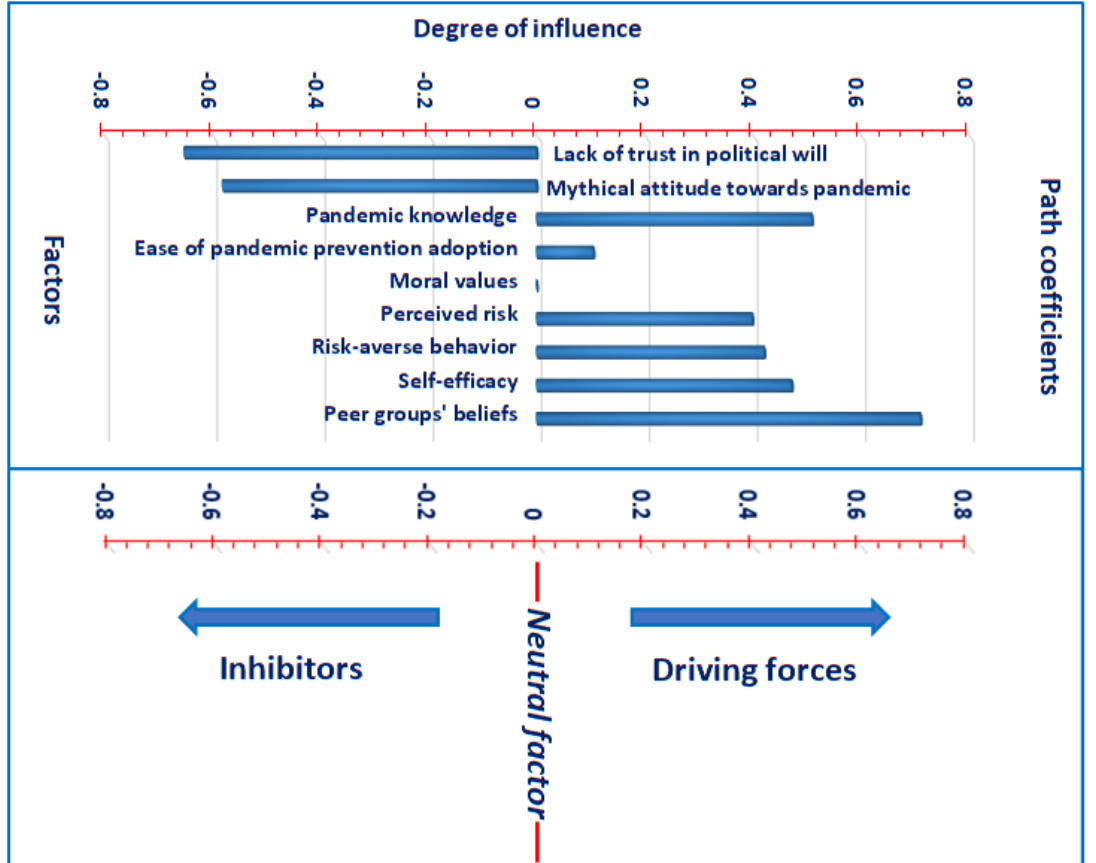
Figure 5. Path coefficients-based classification of factors into driving forces, inhibitors, and neutral factors. Source: Authors’ elaboration.